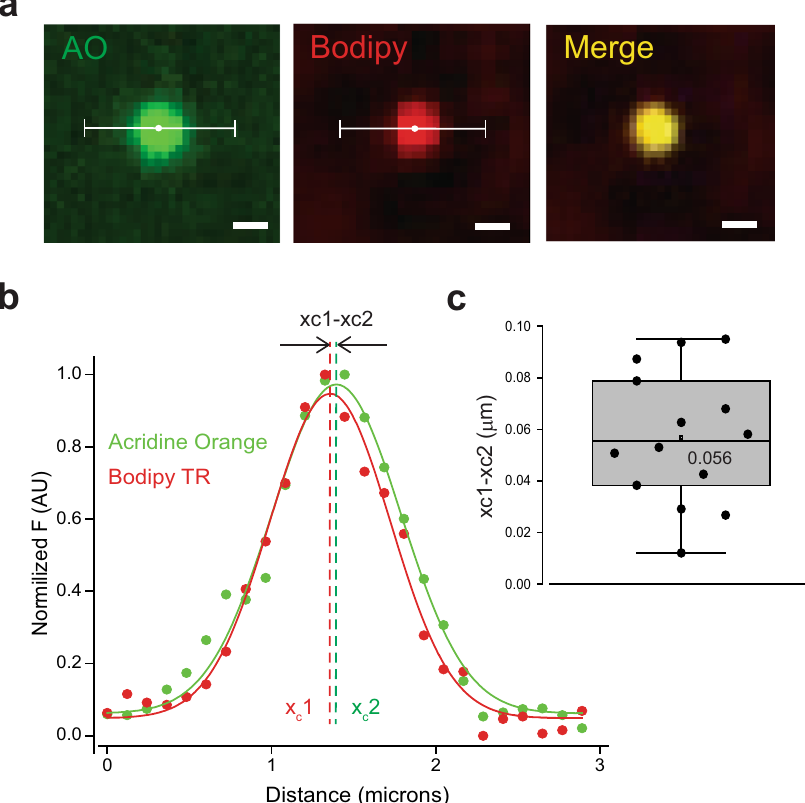
Fig. 4 Double labeling of single EVs for content labeling and pH measurements. a A representative single EV confocal image on NPN membrane labeled with AO (green), Bodipy TR (red), and a merged image (yellow) (scale bar 1 µ m). A bracketed line shows the analysis line cross-section for fl uorescence intensity analysis. b A representative cross-section intensity analysis of labeled EV fl uorescent spot with Gaussian fi ttings (solid line) of normalized data (dots) from two channels: green — AO, red — Bodipy TR. Dashed lines indicate center points ( x c ) of corresponding channels. c Summary box plot for measurements of center point difference (x c 1 − x c 2, median 56 ± 6 nm, n =